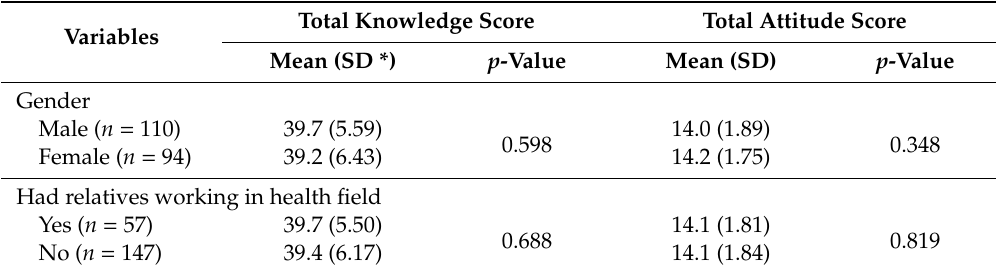
Table 7. Comparing total knowledge and attitude scores between di ff erent genders and having relatives working in the health field using independent t -test ( n = 204). * SD = standard